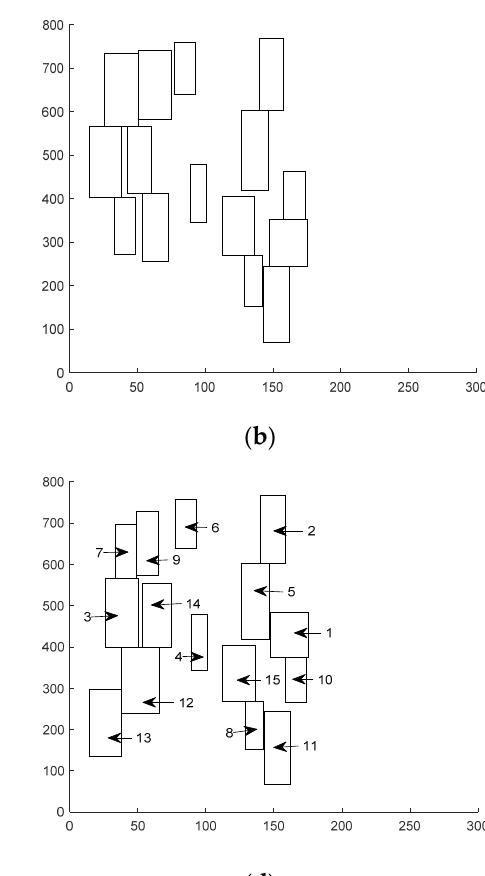
Table 4. The coordinates of the calling ships ( N = 15) after resolving overlaps of ships.